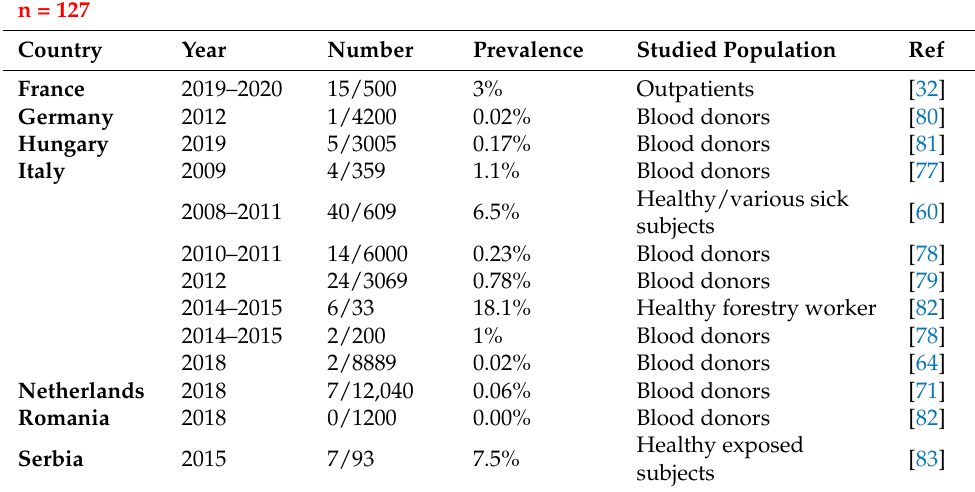
Table 2. Seroprevalence studies of USUV in the European